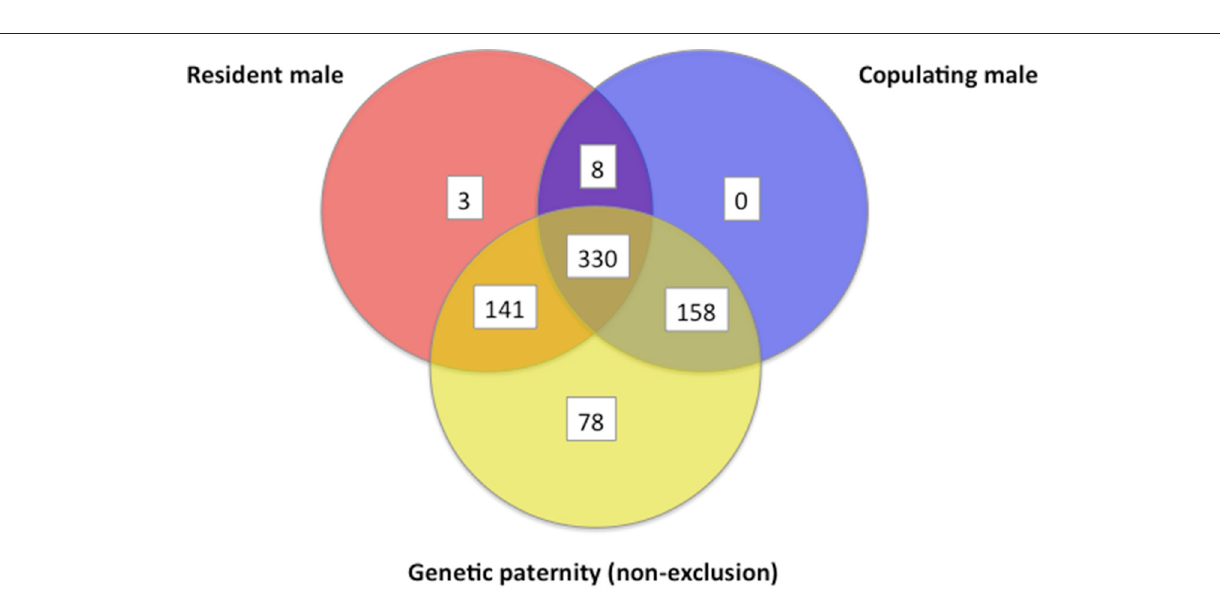
Our research indicates that 83% (226/272) of WTPD females appeared to have only one “social mate” because they lived in a discrete clan with only one male, or shared a male with females living in an adjacent clan. Similar designation of social mates is possible for some species, but not for many other species for which discrete social groupings are not obvious (Birkhead and Moller, 1992; Shuster and Wade, 2003; Danchin et